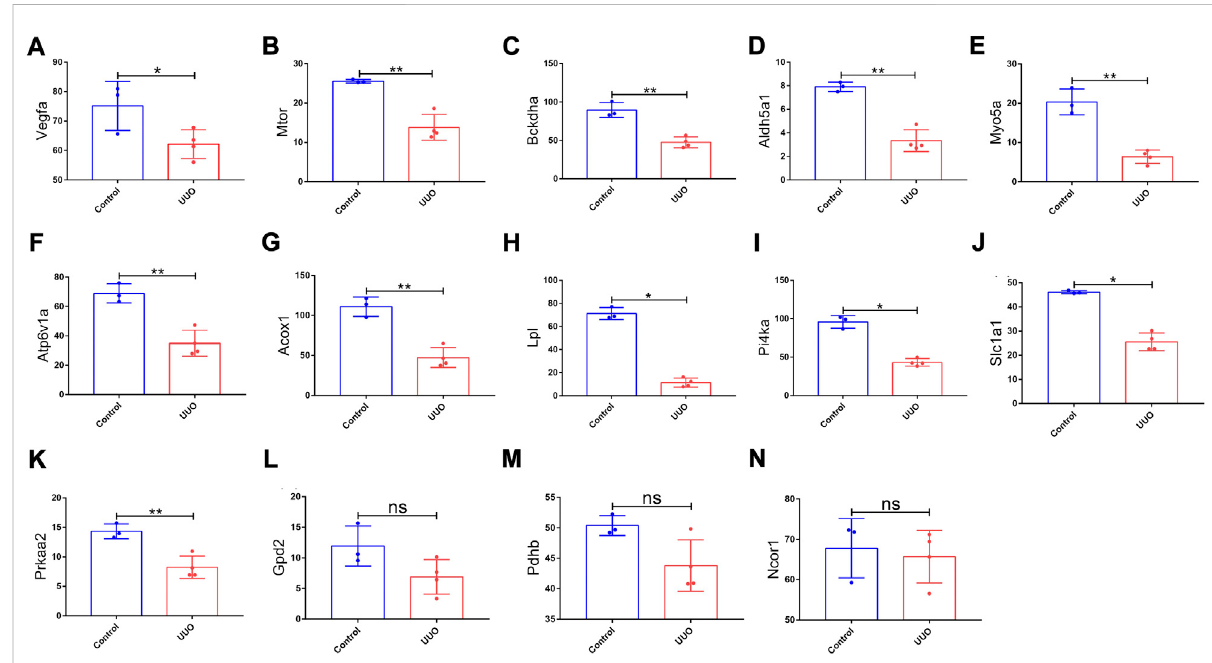
FIGURE 6 Expression levels of 14 genes in the UUO group and control group based on the GSE118339 dataset. The 14 genes were from 26 originally identi fi ed hub genes, which were also detected by the GSE118339 dataset. (A) Vegfa ; (B) Mtor ; (C) Bckdha ; (D) Aldh5a1 ; (E) Myo5a ; (F) Atp6v1a ; (G) Acox1 ; (H) Lpl ; (I) Pi4ka ; (J) Slc1a1 ; (K) Prkaa2 ; (L) Gpd2 ; (M) Pdhb ; and (N) Ncor1 . UUO, unilateral ureteral obstruction; ns, no signi fi cance; * p < 0.05 and ** p <